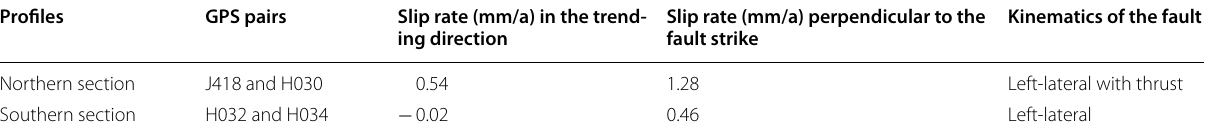
Table 1 Kinematic characteristics of the southern and northern sections of the Huya Fault derived from GPS velocities between 2013 and 2015